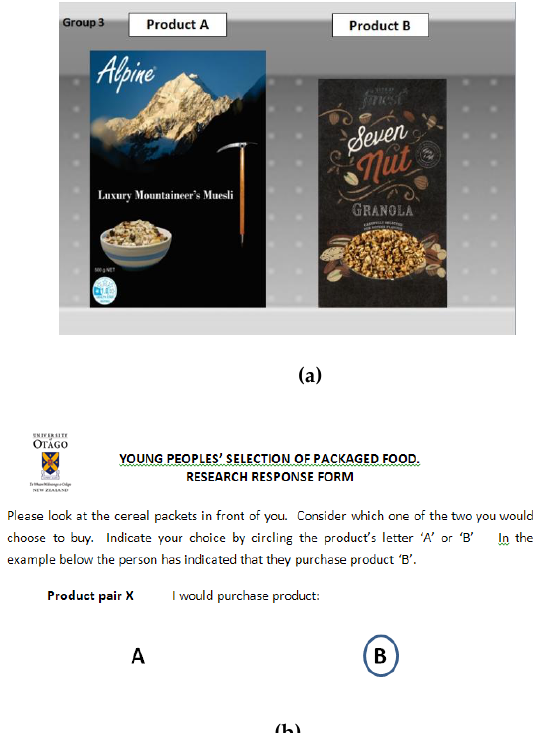
Figure 7. Experimental administration details: ( a ) large scale reproduction of a single-choice diad as shown to each class by on a 1.7 × 1.2 screen. The real products were held up at the same time. ( b ) The response instrument used. In this case, it is the example used to brief each